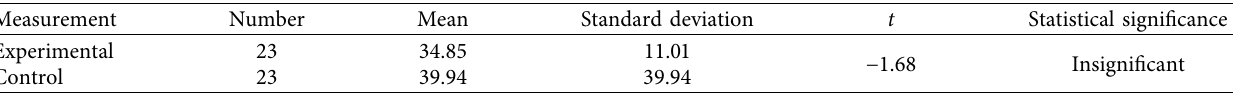
Table 3: t -test and the significance of the differences for achievement in the English language for the two groups: the experimental group and the control